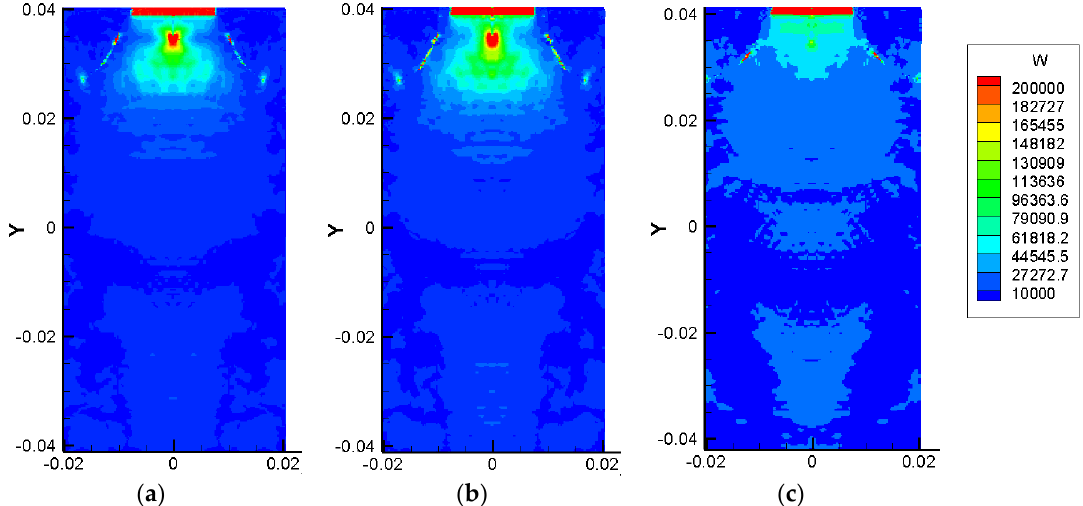
Figure 17. Contours of the elastic energy density in FGM coatings with different thicknesses: ( a ) 8 mm; ( b ) 10 mm; ( c ) 12 mm.